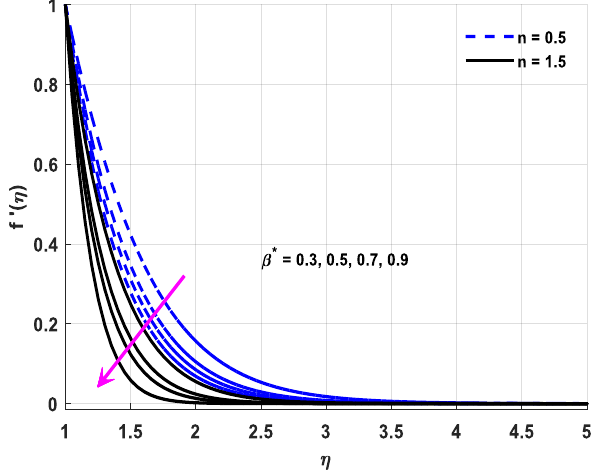
Figure 6. Fluid velocity profile variations owing to changes in β ∗ .